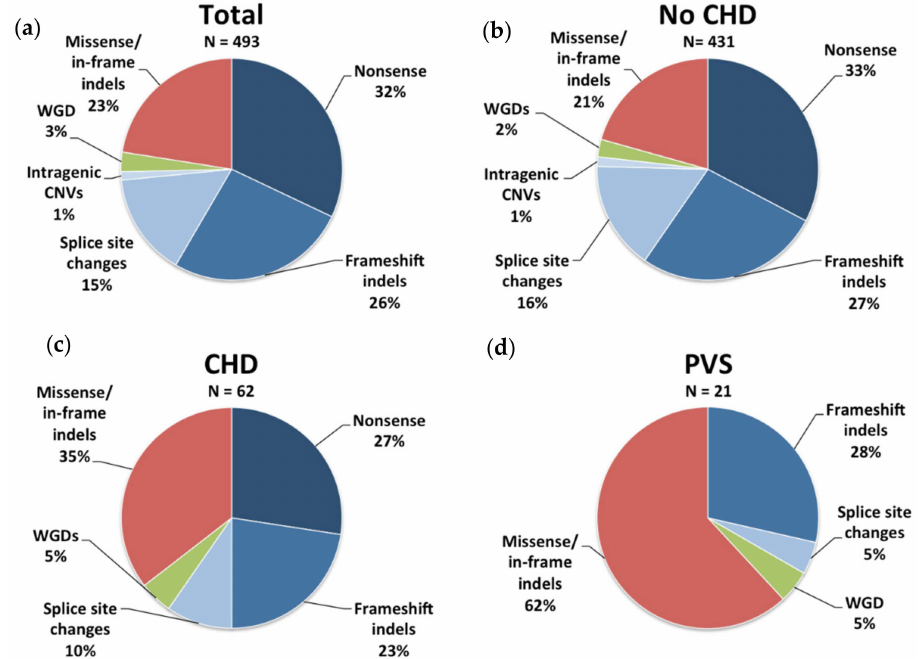
Figure 2. Mutation spectrum of the NF1 gene in the study cohort. Schematic view of the proportion of nonsense mutations, frameshift indels, splice site changes, intragenic copy number variations (CNVs), whole-gene deletions (WGDs), and missense variants / in-frame indels in ( a ) 493 individuals with diagnosis of NF1, ( b ) 431 individuals with diagnosis of NF1 without CHD, ( c ) 62 individuals with diagnosis of NF1 with CHD, and ( d ) 21 individuals with diagnosis of NF1 with